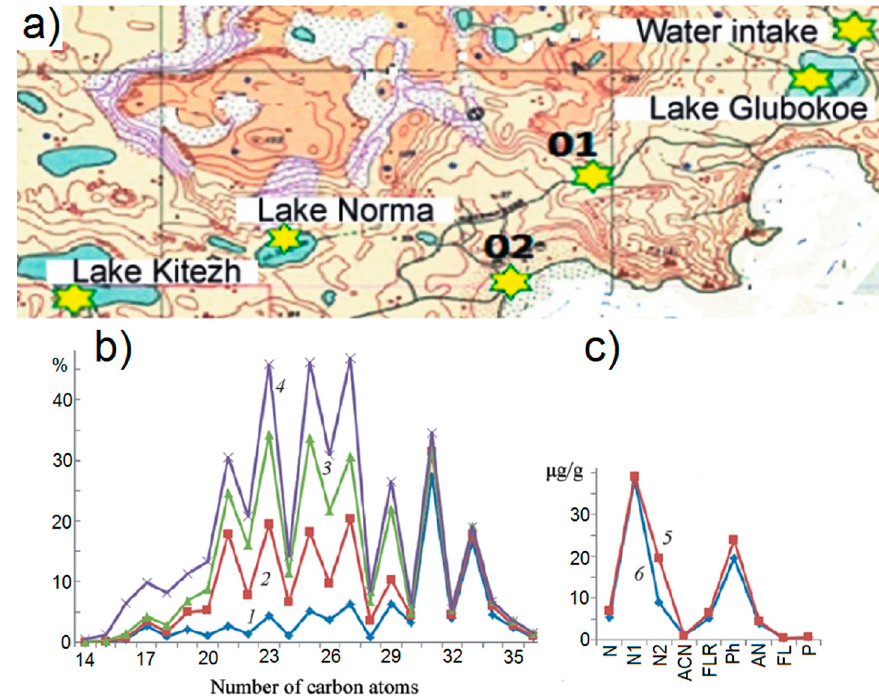
Figure 16. The composition of moss from Bellingshausen Station (2019): ( a ) the location of the sampling areas at Bellingshausen station, ( b ) the concentration of n-alkanes (% of total): 1 – 3— Glubokoe Lake shore; 4— Norma Lake shore; ( c ) PAH concentration: 5 , 6 —Glubokoe Lake shore. N–